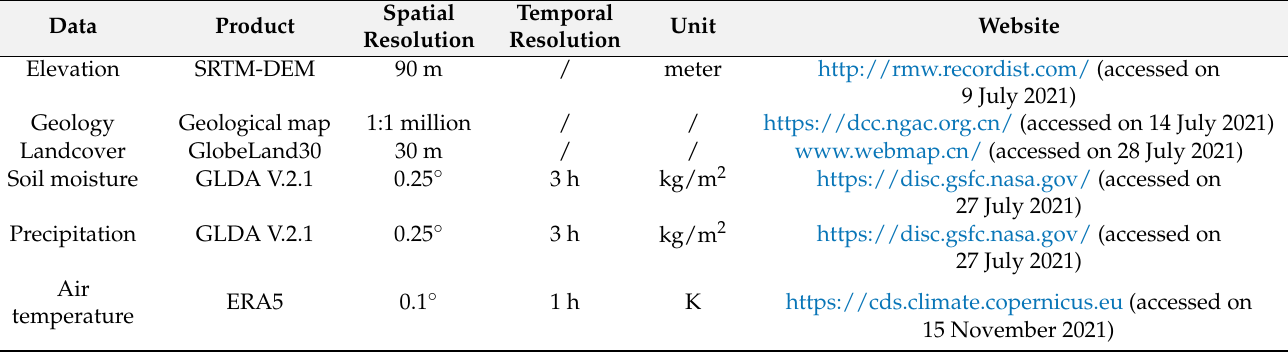
Table 3. Auxiliary data used in this